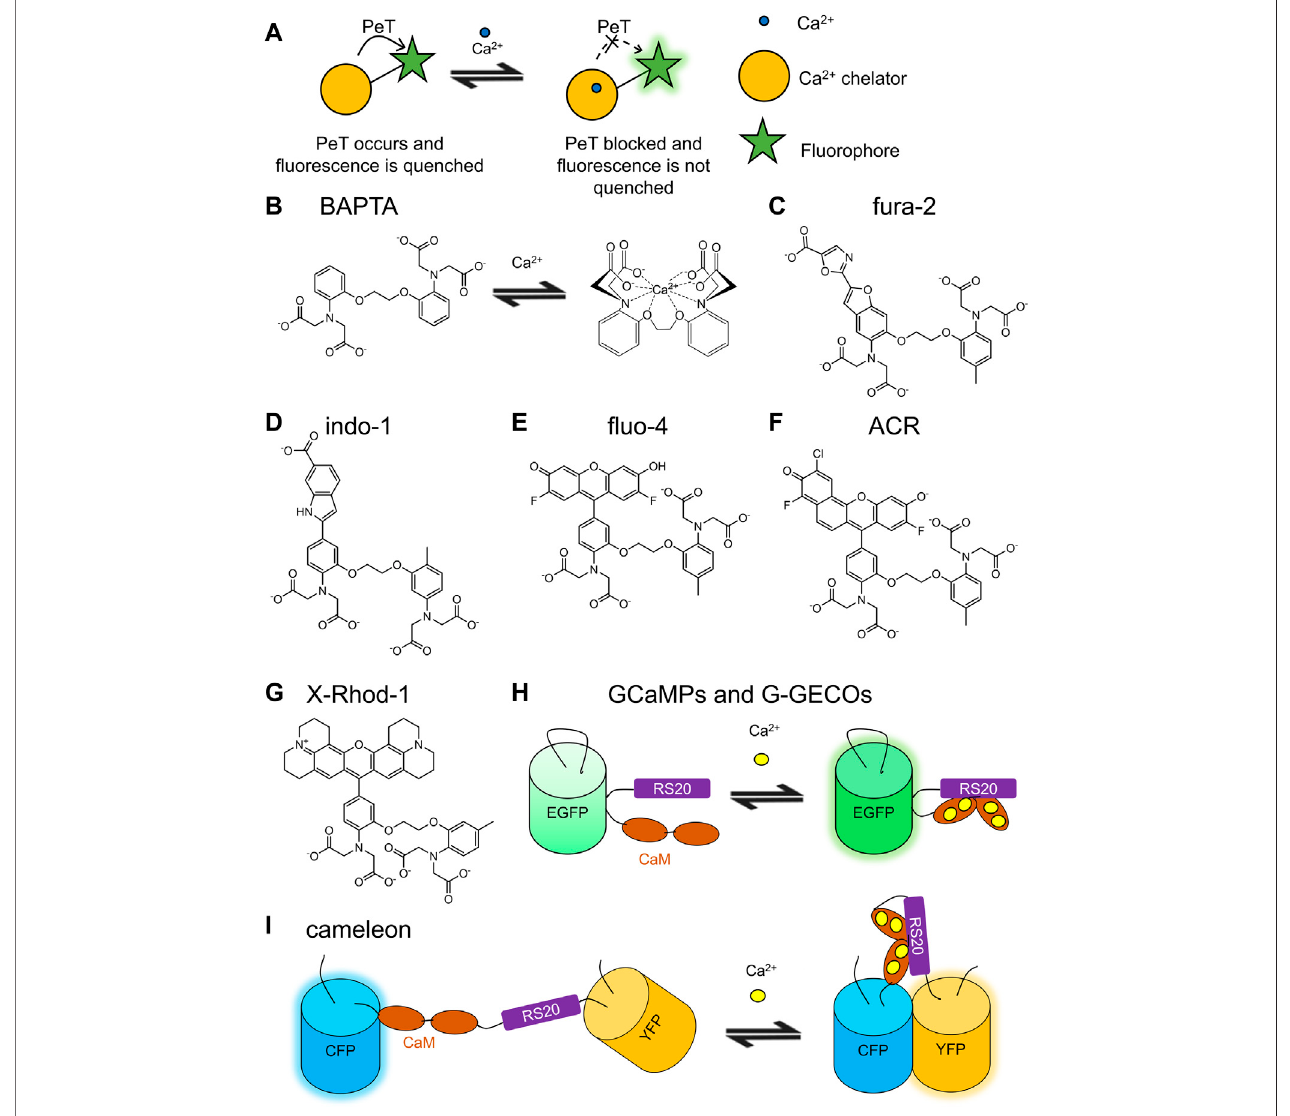
FIGURE 1 | Schematic representations and molecular structures of selected small molecule-based Ca 2+ indicators and schematic representations of selected GECIs. (A) Photoinduced electron transfer (PeT) is the typical mechanism used by small molecule-based Ca 2+ indicators (Aigner et al., 2011, 2). For indicators with positive responses, the fl uorophore is quenched by the electron-rich Ca 2+ chelator via PeT in the unbound state. The binding of Ca 2+ reduces PeT-induced quenching, leading to brighter fl uorophore. (B) BAPTA is the Ca 2+ -binding motif for many small molecule-based Ca 2+ indicators (Tsien, 1980). The binding of Ca 2+ constrains themolecularstructure ofBAPTA,leadingtoaspectralchange. (C) Fura-2and (D) indo-1arebothderivedfromBAPTA andexhibitblue togreenemission (Grynkiewicz et al., 1985). (E) Fluo-4 is based on a modi fi ed fl uorescein fl uorophore and exhibits bright green emission (Gee et al., 2000). (F) Rhodamine-based Asante Calcium Red (ACR) and (G) X-Rhod-1 exhibit red fl uorescence (Tsien and Minta, 1991; Hyrc et al., 2013). (H) GCaMPs and G-GECOs are based on CaM/RS20 and cpEGFP (Nakai et al., 2001; Zhao et al., 2011). (I) Cameleon series is FRET-based GECIs, which show increased YFP fl uorescence with Ca 2+ binding (Miyawaki et al., 1997).